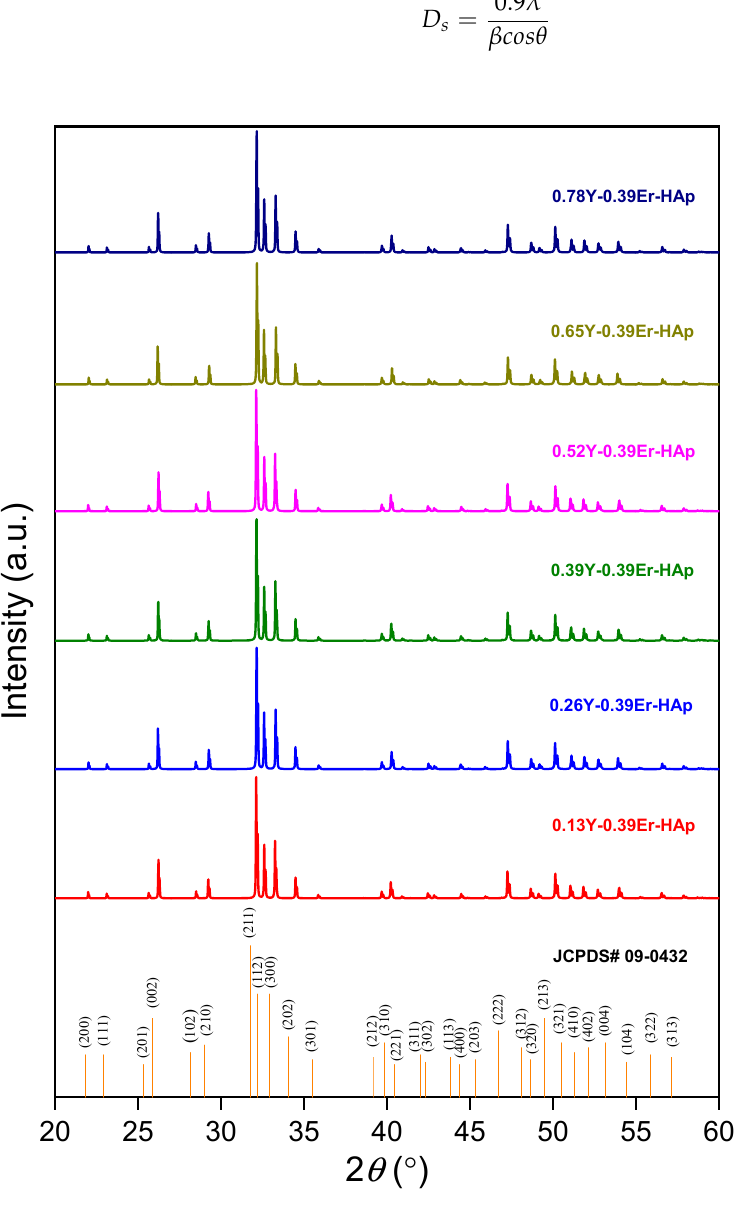
Figure 1. XRD patterns of the samples. Further, Williamson–Hall ( D WH ) plot was used to evaluate strain as Equation (2) [29].